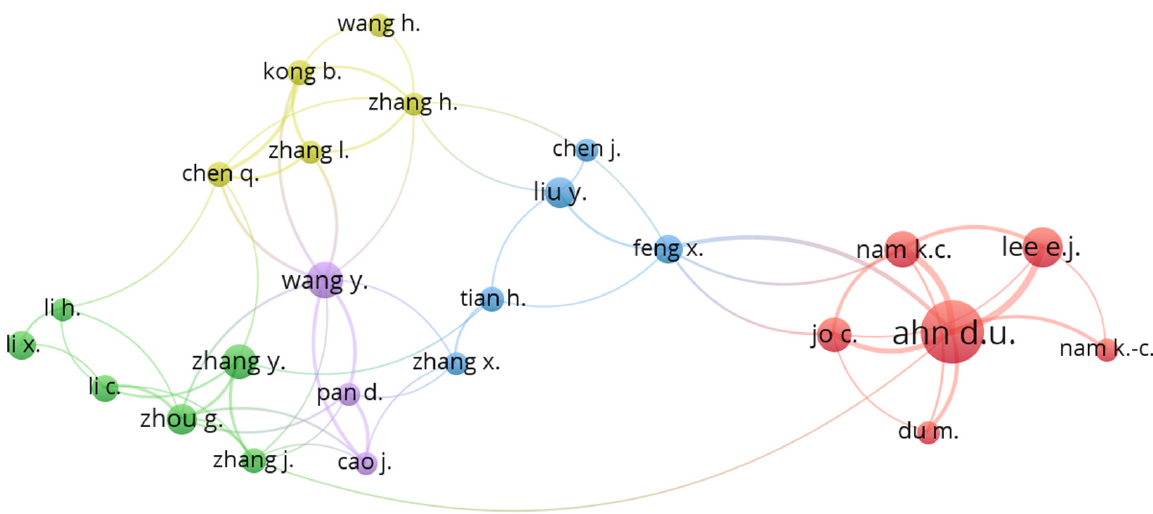
Figure 2. Main networks of the authors’ collaborations. The inclusion criteria were authors with more than 5 published papers and engaged in collaborations (authors working alone excluded). All together there were 88 connections, but only the 25 most closely connected are shown here. The size of the circles represents the number of papers, while the thickness of the lines represents the strength of the collaboration in terms and numbers of joint publications and their proportion of the total. Bigger circles and thicker lines indicate higher productivity and stronger collaboration between the two authors.